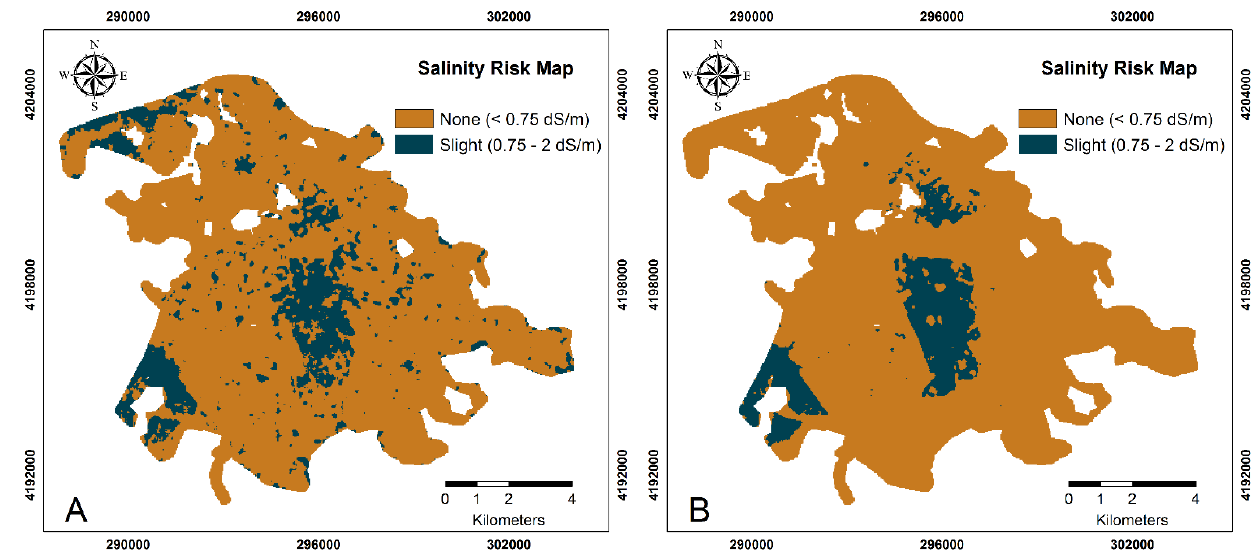
Figure 5. Salinity risk assessment maps. A : Random forest, B : support vector regression.